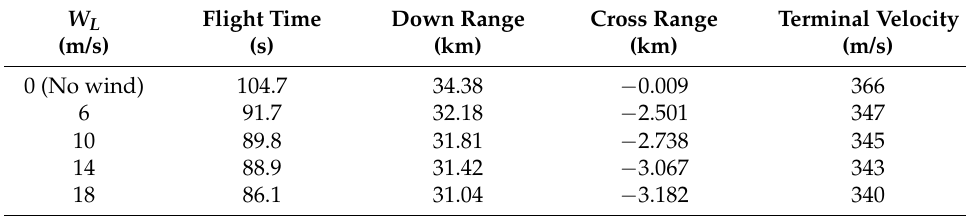
Table 7. Main ballistic parameters with different w L